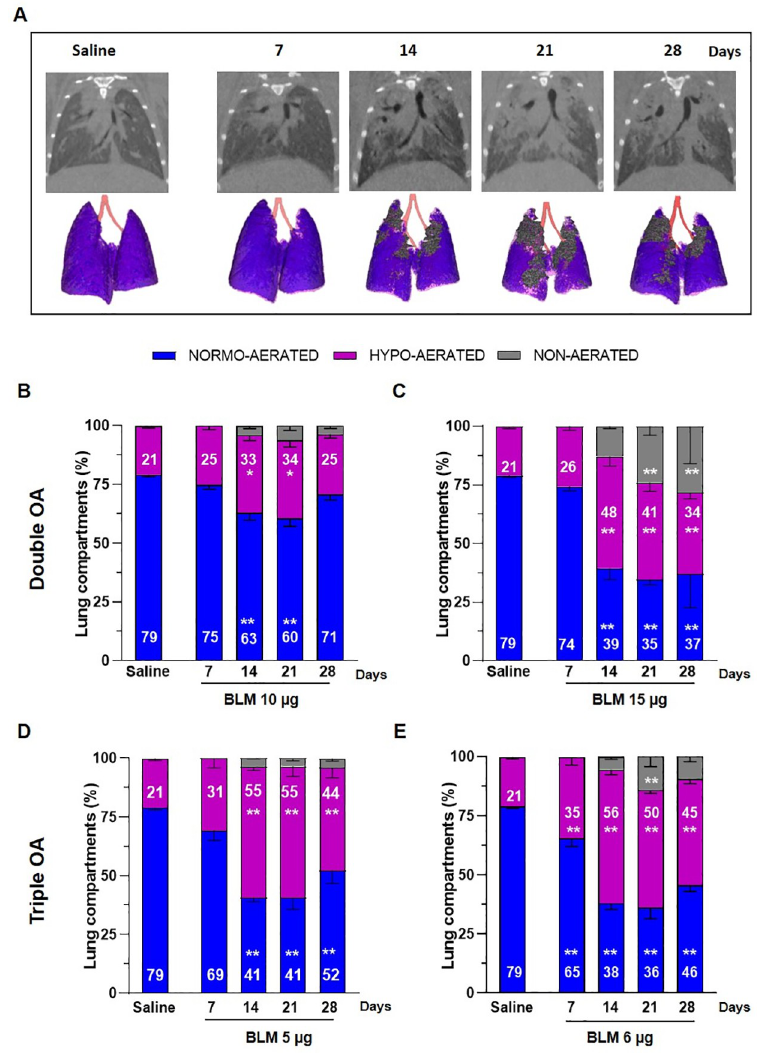
Fig 2. Longitudinal micro-CT assessment. (A) Representative coronal micro-CT lung slices and 3D renderings at the end of expiration phase of saline- and BLM-treated mice at 7, 14, 21 and 28 days. (B-E) Lung aeration degrees expressed as percentage of normo-, hypo-, and non-aerated tissues detected at 7, 14, 21, 28 days for the saline group and BLM groups at different dose regimens. Data are shown as mean ± SEM. The statistical analysis was performed for each group compared to saline via two-way ANOVA followed by Dunnett’s test ( � p < 0.05; �� p < 0.01 vs. saline). N = 5 per group.